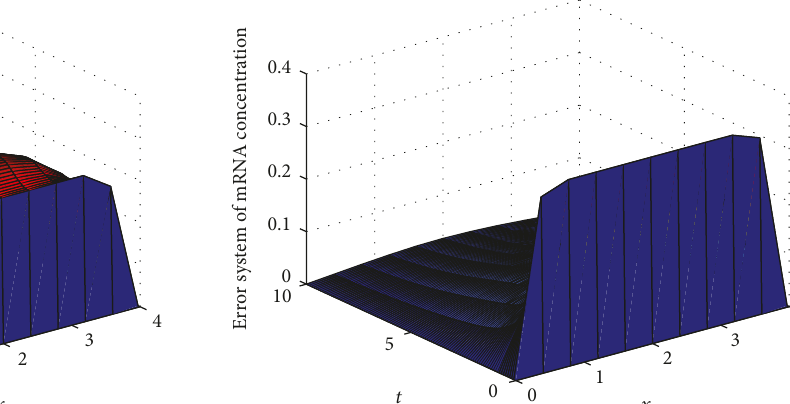
Figure 5: The mRNA concentrations of error system ( e 2